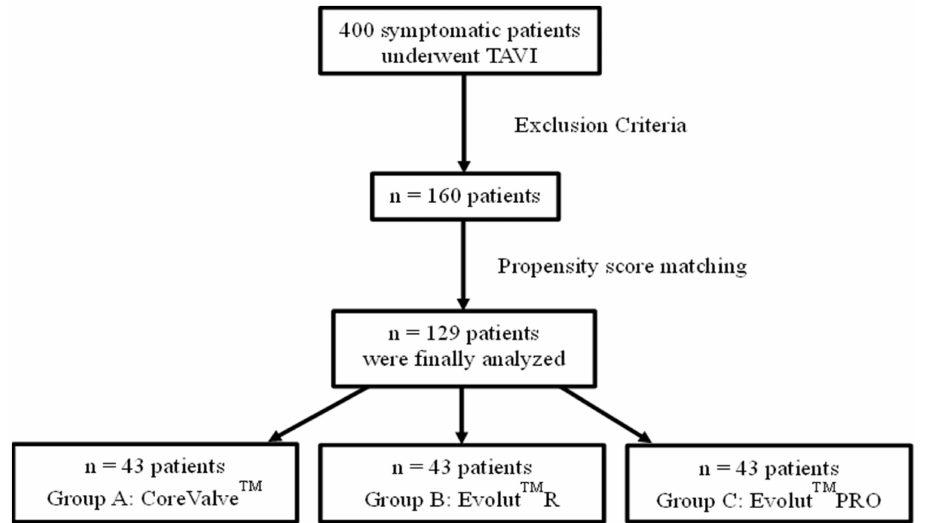
Figure 1. Flow diagram of the study